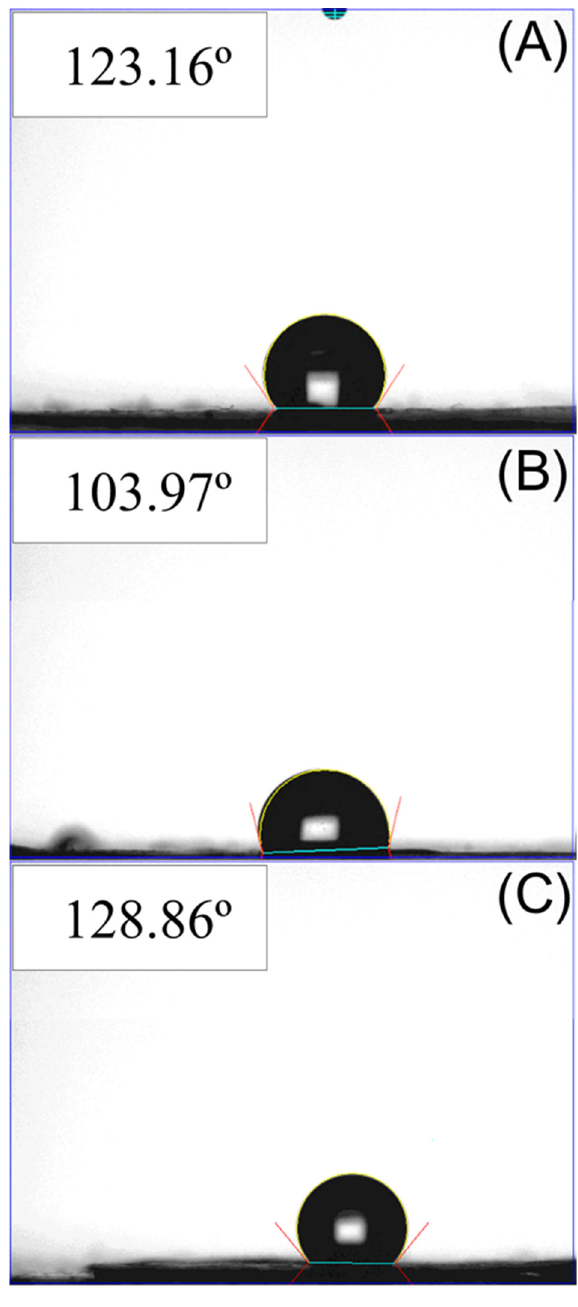
Figure 7. Wetting angles of ( A ) virgin PLGA nanofibers, ( B ) drug-loaded nanofibers, and ( C ) BMP- 2-loaded